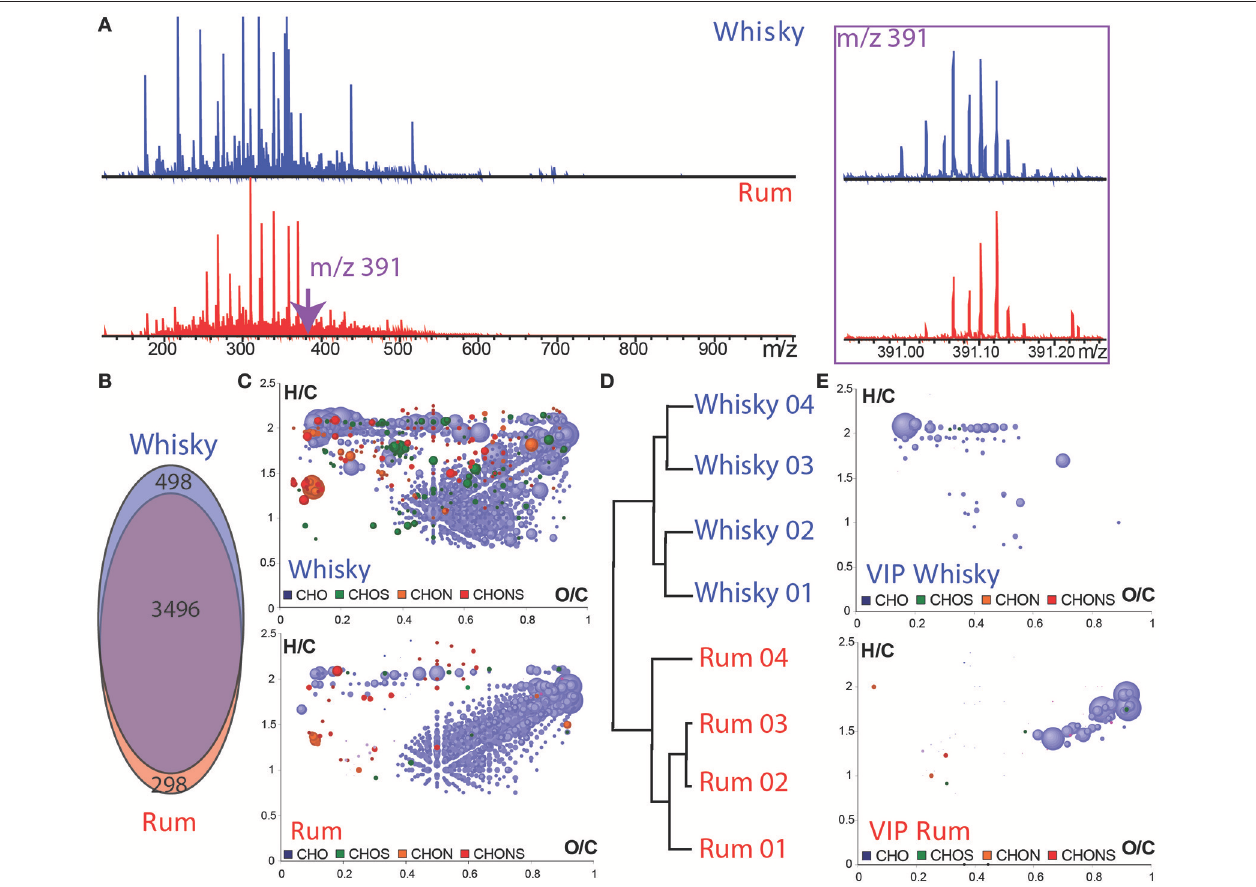
FIGURE 5 | Raw FT-ICR-MS mass spectra of whisky and rum samples (A) in the mass range from m/z 100–1000 Da and enlargement of the nominal mass m/z 391. (B) Common and unique features found for whiskies and rums. (C) Van Krevelen diagrams (H/C vs. O/C atomic ratio) of the whisky and rum samples. (D) Hierarchical cluster analysis of whiskies and rums. Points in van Krevelen diagrams are colored according to their elemental composition, CHO in blue, CHOS in green, CHON in orange, and CHONS in red. Scaling according to the peak intensity. (E) Van Krevelen diagrams for the “VIP” features, which contribute to the HCA discrimination of whisky and rum